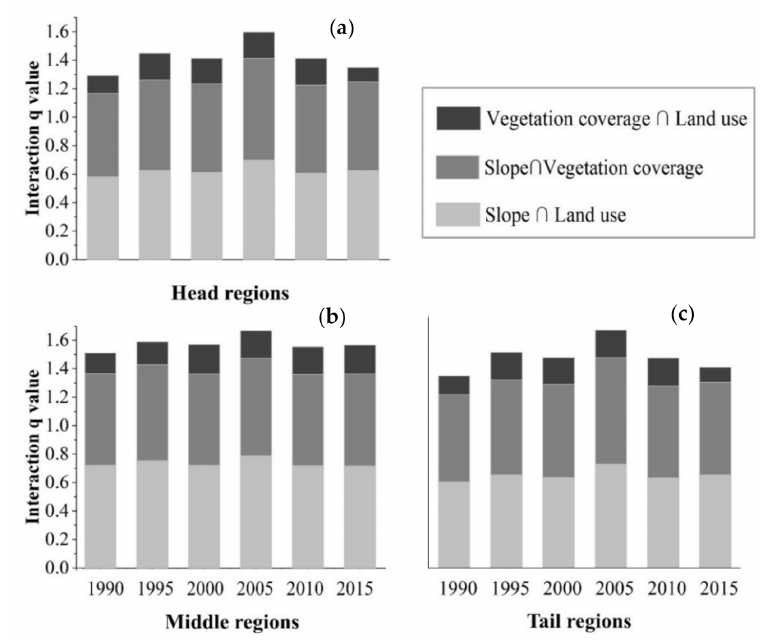
Figure 10. The three most dominant interaction factors in di ff erent regions of the TGRA from 1990 to 2015—( a ) head region; ( b ) middle region; ( c ) tail region.